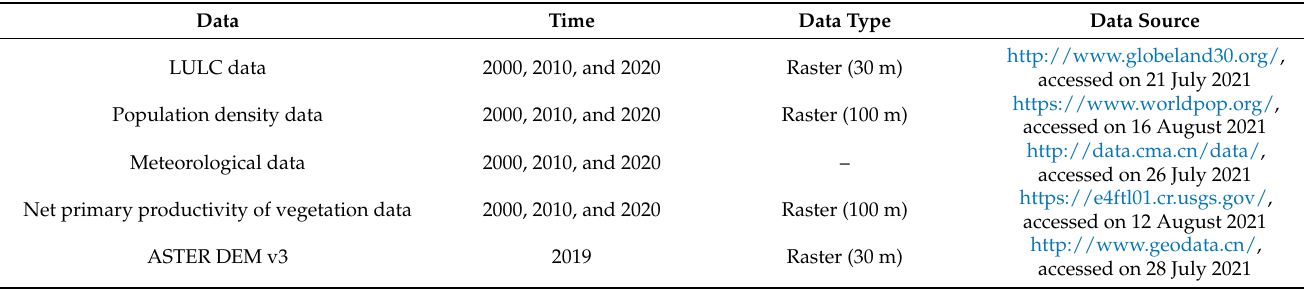
Table 1. Summary of data involved in the study.